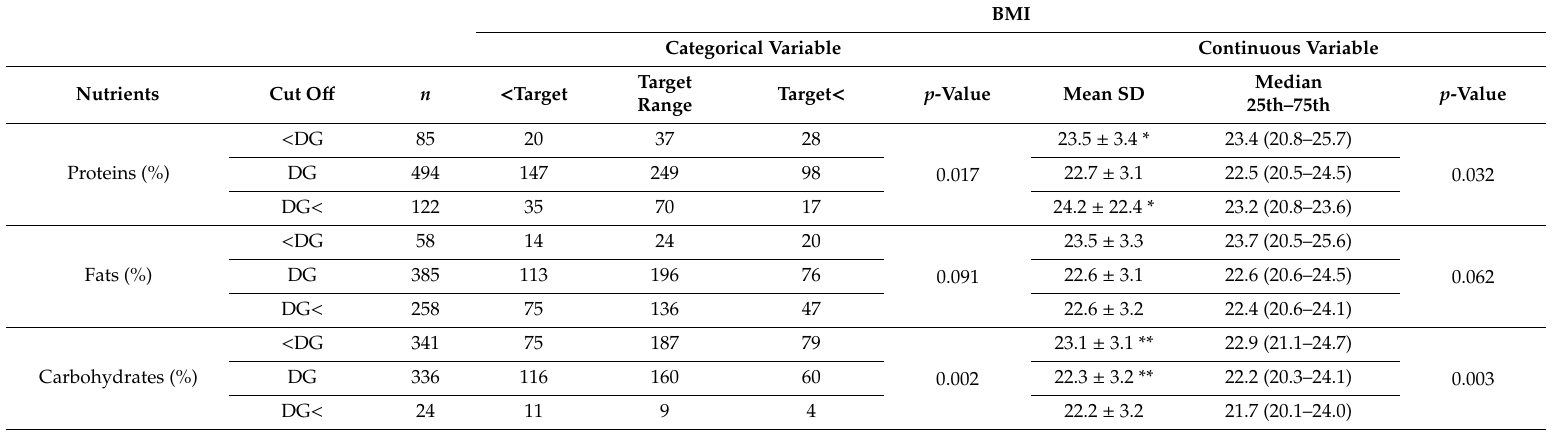
Table 1. BMI and three macronutrients